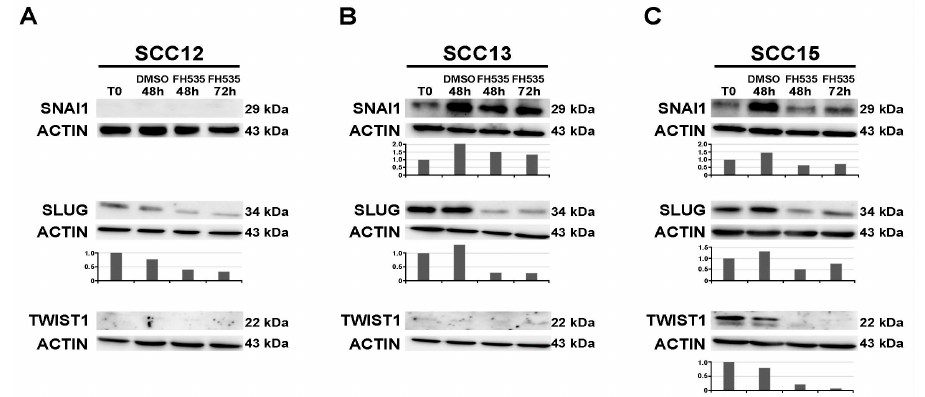
Figure 4. Western blot analysis of SNAI1, SLUG and TWIST expression (29 kDa, 34 kDa and 22 kDa respectively) in SCC cell lines treated with FH535. T0 refers to the beginning of the treatment with FH535 or DMSO. Panels ( A – C ) show repressors’ expression following treatment in SCC12, SCC13 and SCC15 cells respectively. The plot below indicates the normalized densitometric analysis of immunoblot.